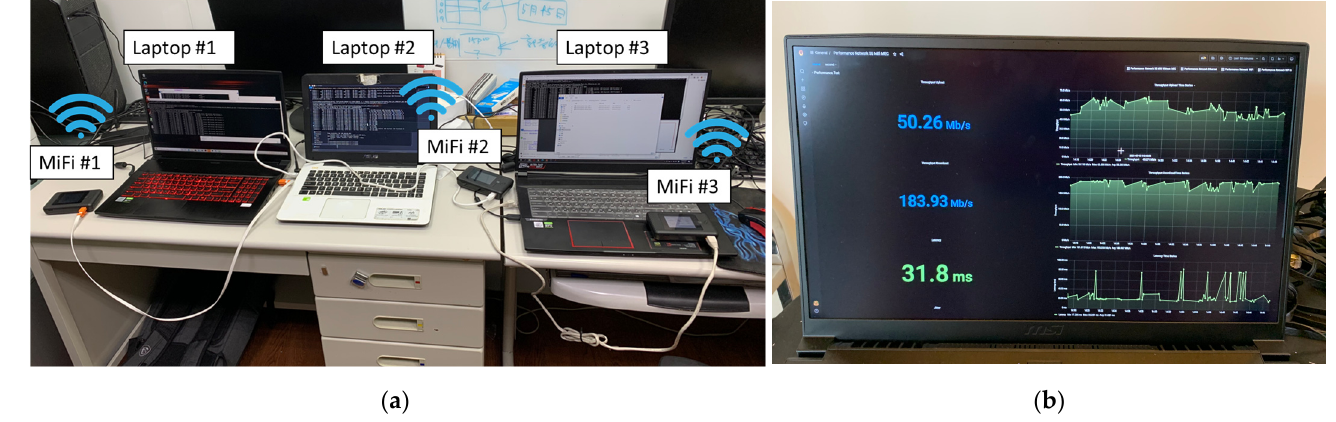
Figure 5. Equipment setup and measurement in the display. ( a ) Laptop and MiFi (5G router) setup. ( b ) Network speed and latency measurement.